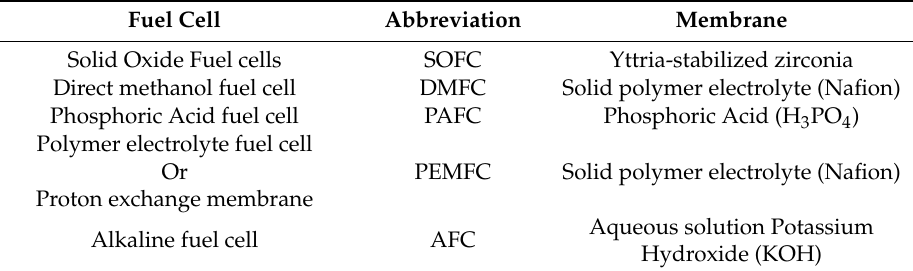
Table 1. Classification of fuel cell systems based on the employed membrane [40].